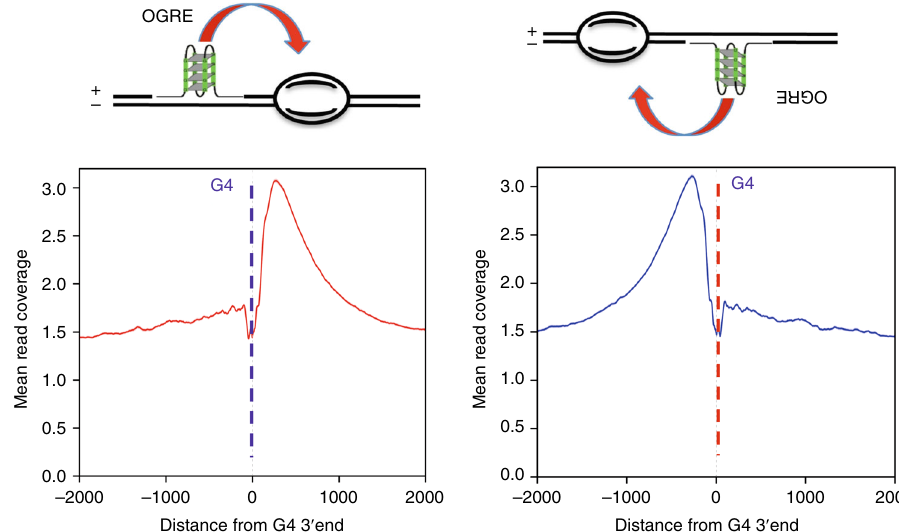
Fig. 7 G4 function in the DNA replication initiation. Based of the position of the OGRE/G4 that we already reported 2 and the corresponding model 3 , we know that the OGRE/G4 element is always upstream of the initiation site itself, either on the + or the − DNA strand (left and right upper panels). In the corresponding lower panels, based on our present data, we con fi rm again the position of the G4 element relative to the initiation site. The position of the G4 might fi t with the position of the preRC, but this does not obligatory imply it will recruit some factors to the pre-RC. First, G4 can adopt several types of structure which themselves might regulate the folding or the replication origin region. Second, G4 might play a role in the removal of the nucleosome positioned at the initiation site itself, a process necessary to load the replication machinery, and therefore regulate activation of DNA replication. Third, because G4 are themselves nucleosome-free regions, they could facilitate DNA helix opening at the initiation